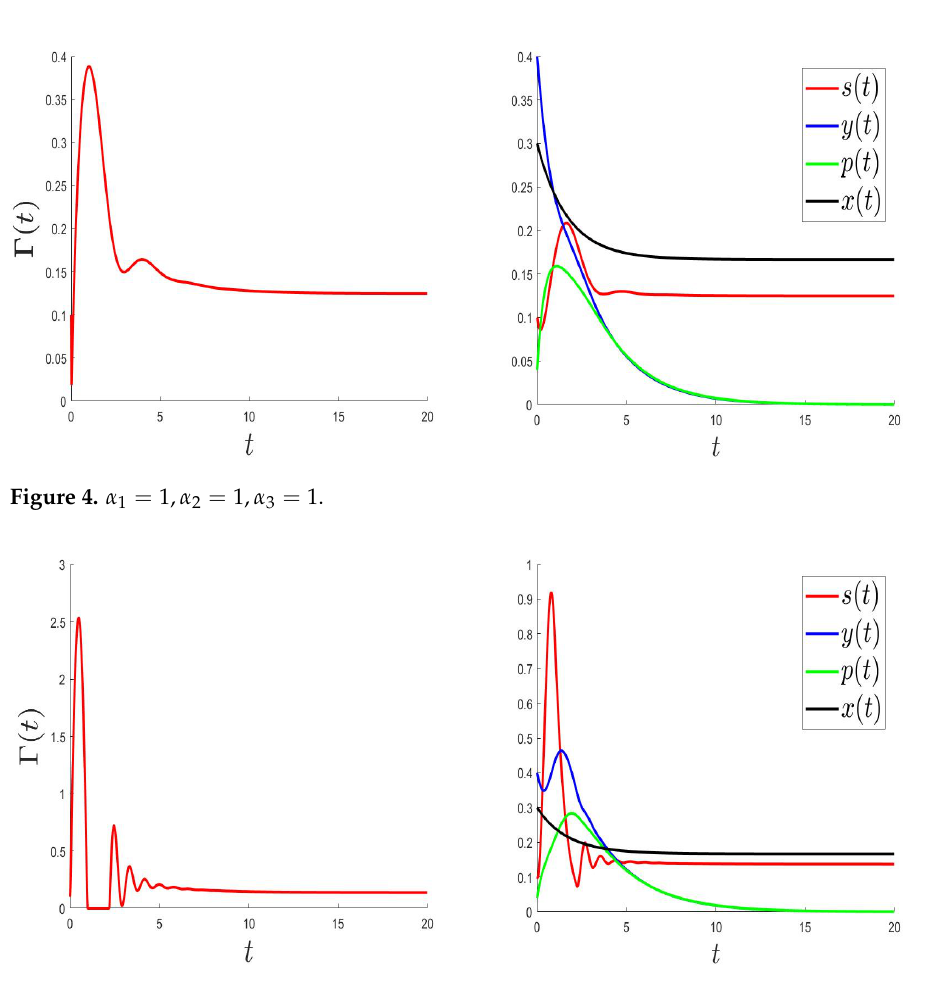
Figure 5. α 1 = 1, α 2 = 1, α 3 =